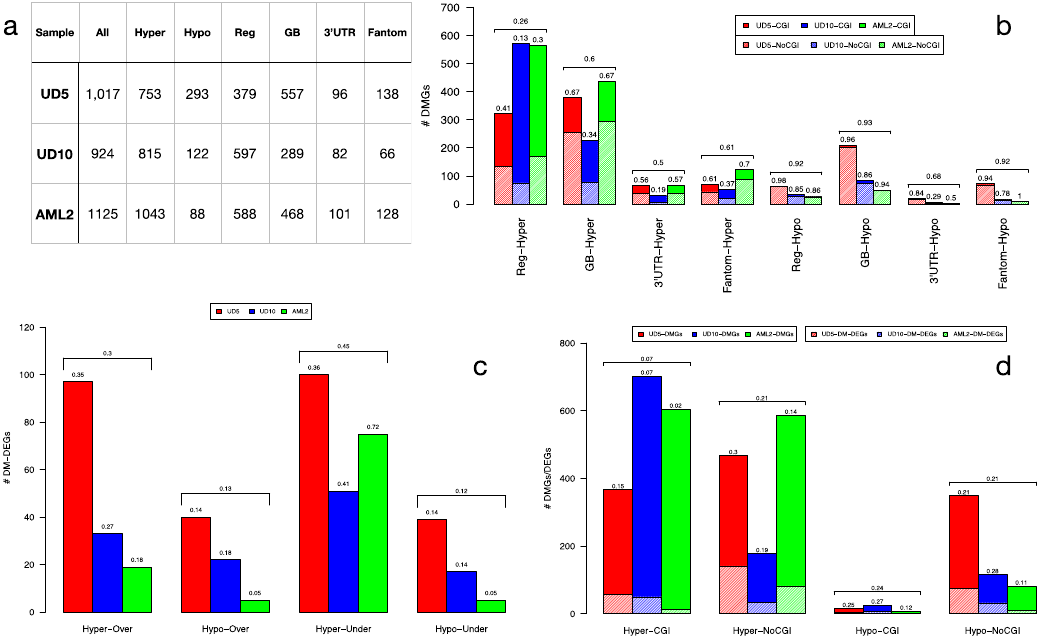
Fig. 2 DMRs functional classi fi cation. Table in ( a ) reports the number of genes affected by all, hyper-methylated (Hyper) and hypo-methylated (hypo) DMRs. For each patient we also report number of genes with DMRs overlapping 5' regulatory region (Reg, including 1 – 5 kb from TSS, promoters, fi rst exons and 5'UTRs), gene-body (GB, including internal introns and exons), 3'UTR and enhancers (genes predicted by FANTOM to be regulated by enhancers). The discrepancy between total number of genes (All) and the sum of Reg, GB and 3'UTR is due to the fact that few genes have DMRs in more than one genic element. The barplot of ( b ) reports the total number of DM genes with DMRs in all regions (All, both inside and outside CGIs), inside CpG islands (CGI) and outside CpG islands (NoCGI) at different genomic elements (5' regulatory region, Reg, internal introns and exons, GB, 3'UTR and enhancers of Fantom Genes). Textured bars show the number of DMGs with DMRs in sparse CpG regions (NoCGI). Numbers above bars show the percentage of DMGs in sparse CpG regions. Horizontal brackets above each group of three bars summarize average percentages of the three samples. The barplot of ( c ) reports the total number of DM-DEGs for the four regulatory categories: over-expressed genes with hyper-methylated DMRs (Hyper-Over), over-expressed genes with hypo-methylated DMRs (Hypo-Over), under-expressed genes with hyper-methylated DMRs (Hyper-Under), under-expressed genes with hypo- methylated DMRs (Hypo-Under). Numbers above each bar show the relative percentage of DM-DEGs with respect to all DM-DEGs for each sample. Horizontal brackets above each group of three bars summarize average percentages within the three samples. The barplot of ( d ) report the number of hyper- and hypo-methylated DM-DEGs with respect to total number of DMGs in CGIs and sparse CpG regions (NoCGI). Textured bars show the number of DM-DEGs. Numbers above each bar show the percentage of DM-DEGs with respect to DMGs. Horizontal brackets above each group of three bars summarize average percentages within the three